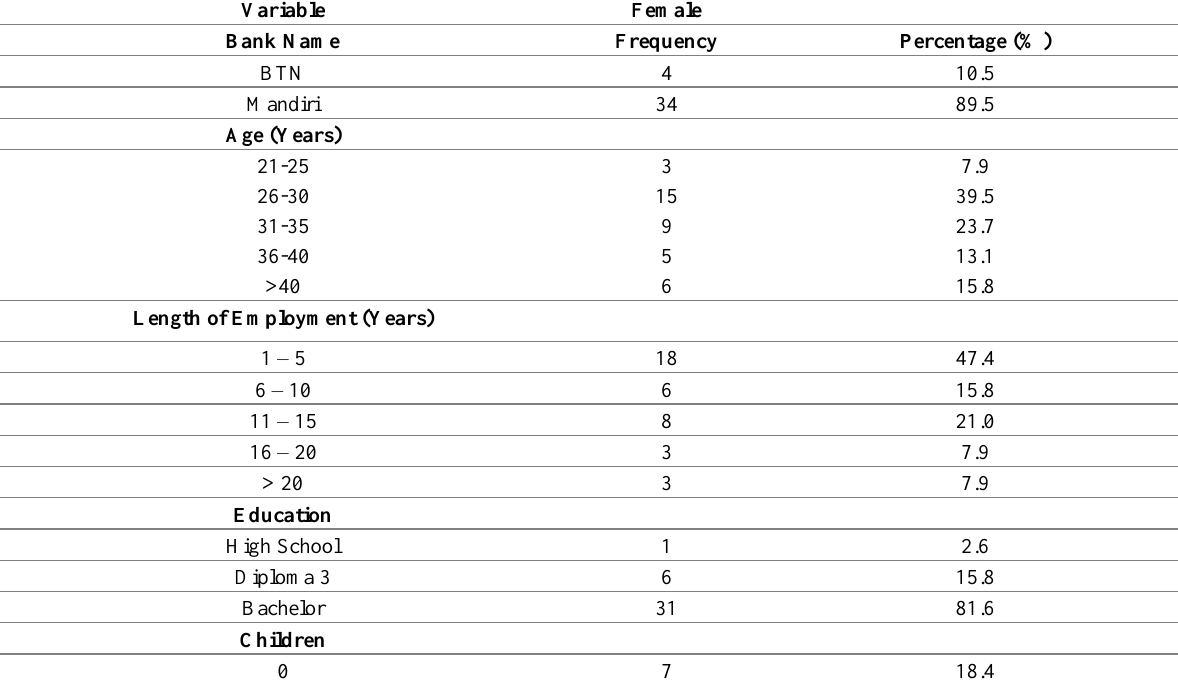
Table 1: Respondent’s